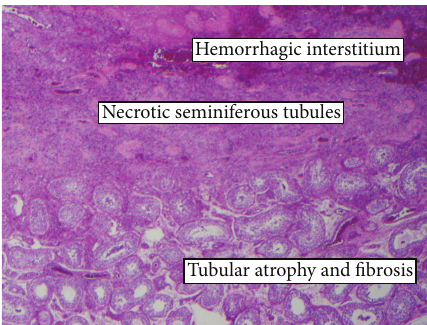
Figure 3: Section shows a well-defined area of infarction sur- rounded by an area of fibrosis and tubular atrophy. Outlines of the tubules are remaining but loss of nuclear details and hemorrhagic with hemorrhagic interstitium. There is no significant inflammation or evidence of